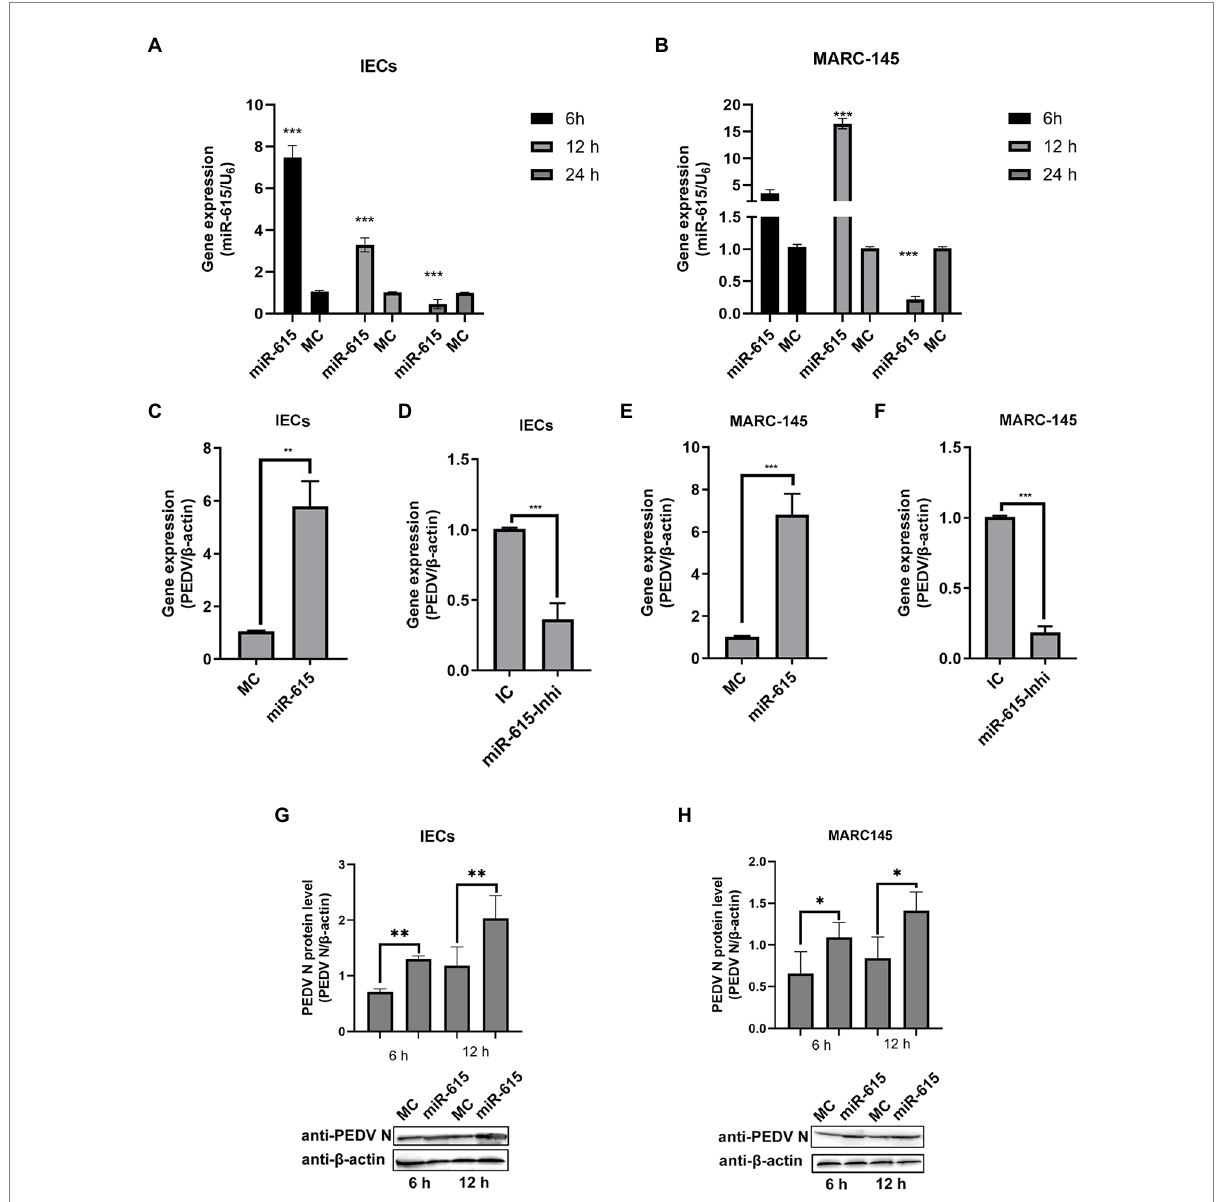
FIGURE 2 miR-615 facilitates PEDV infection in MARC-145 cells and IECs. (A and B) PEDV regulated miR-615 expression in IECs and MARC-145 cells. IECs (A) and MARC-145 cells (B) were infected with PEDV at a multiplicity of infection (MOI) of 1 and samples were collected at 6, 12, and 24 h post- infection. RT-qPCR was used to assess miR-615 expression. (C–F) IECs and MARC-145 cells were transfected with the MC, miR-615 mimic, IC, or miR-615 inhibitor (100 nmol). After 24 h, the cells were infected with PEDV at an MOI of 1. After 18 h, the PEDV genomic RNA of the MC, miR-615 mimic, IC, and miR-615 inhibitor in the IECs (A,B) and transfected MARC-145 cells (C,D) were assessed using RT-qPCR. PEDV N protein level was measured using western blotting following transfection with the MC or miR-615 mimic for 6 and 12 h in the IECs (G) and MARC-145 cells (H) . The intensity represents PEDV N protein levels normalized against that of β -actin across three independent experiments in IECs and MARC-145 cells, respectively. The data are presented as the mean ± SD of three independent experiments, performed with technical duplicates. * p <0.05, ** p < 0.01, *** p <